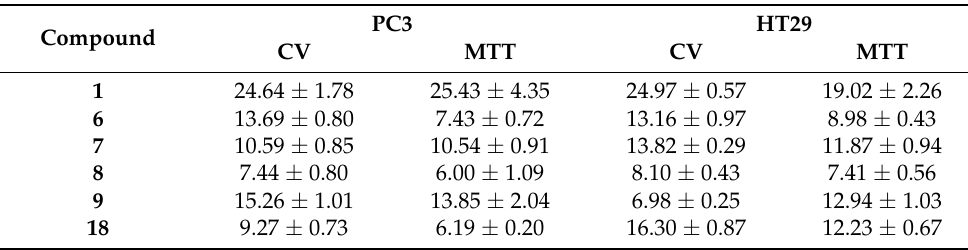
Table 1. IC 50 values ( µ M) for the most active compounds against HT29 and PC3 cell lines determined by MTT and CV assays.